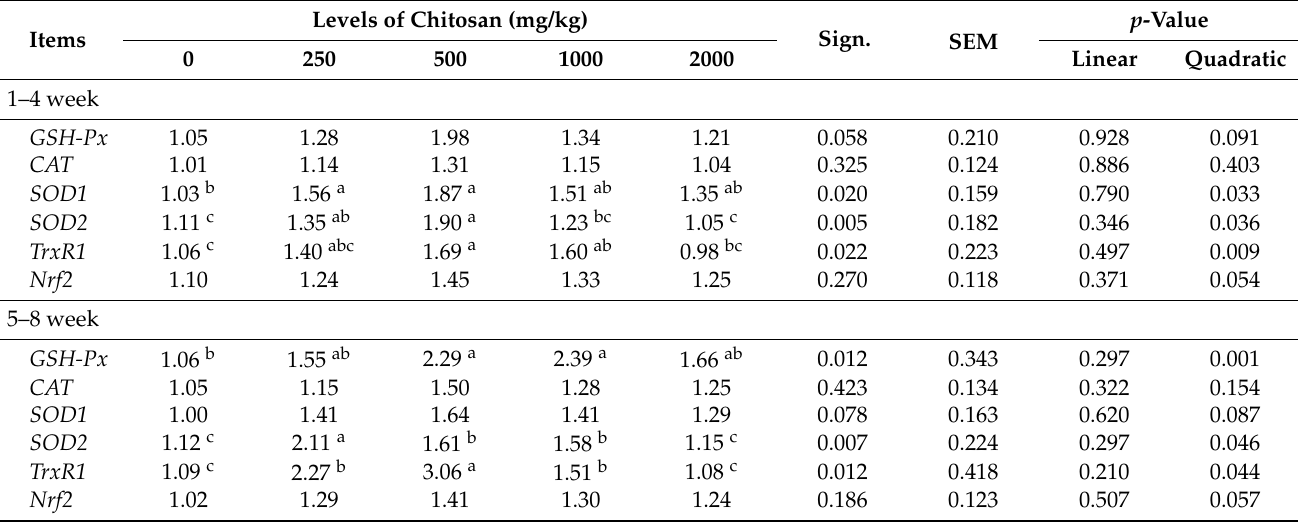
Table 8. Effect of dietary chitosan supplementation gene expression of antioxidant enzymes in